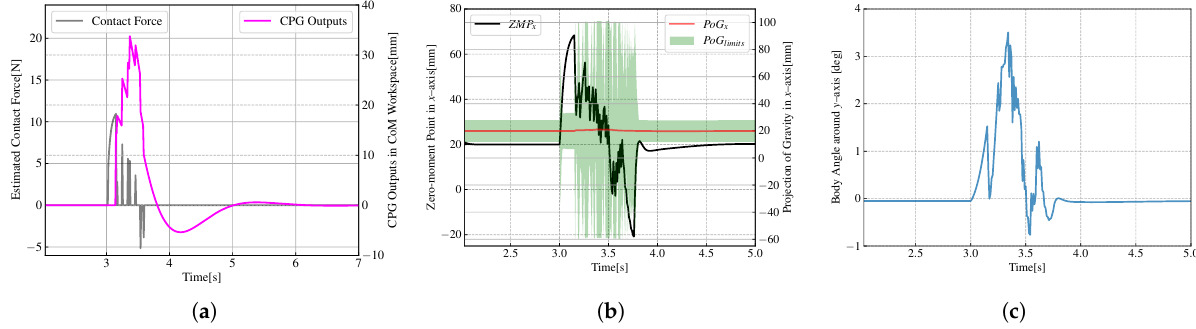
Figure 7. Variations of variables when the robots standing on double feet with CPG. ( a ) Variations of contact force and CPG output. ( b ) Variations of ZMP, the estimated projection of gravity (PoG) and the limit of PoG. ( c ) Variations of body angle.